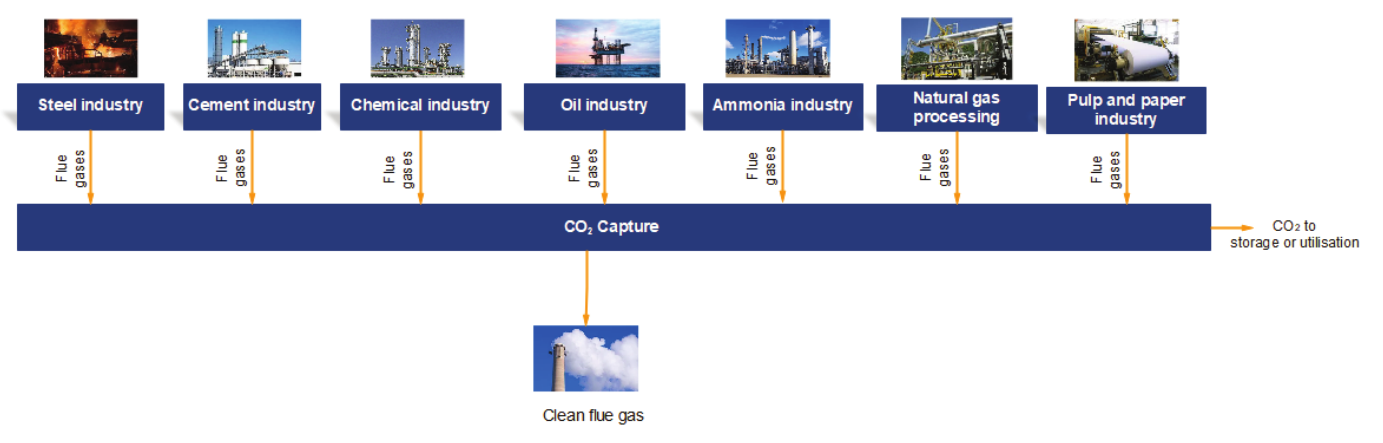
capture from hard-to-abate 2